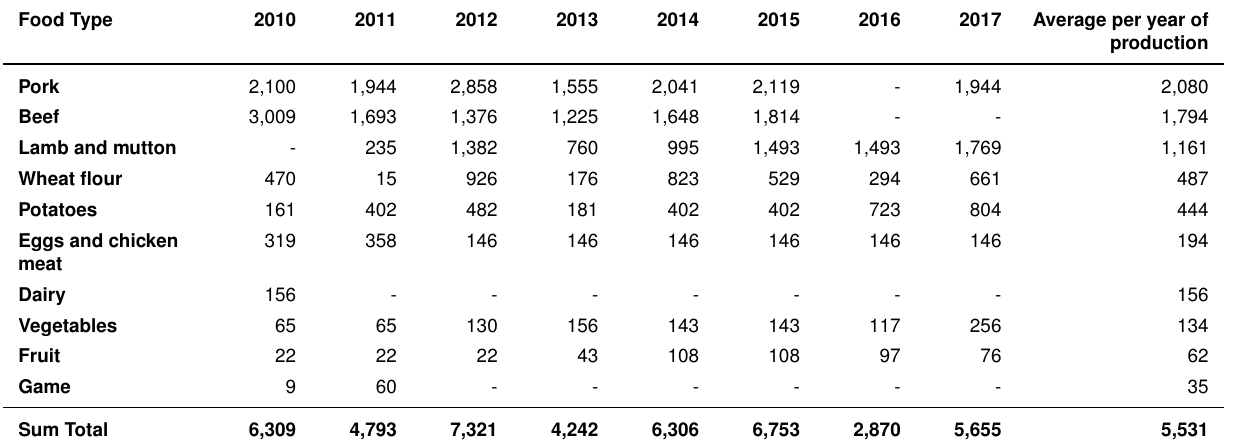
Table 7. Energy content of food produced (MJ), 2010–2017.